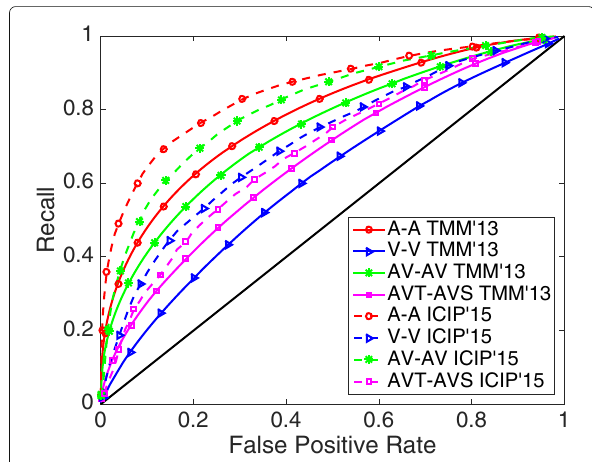
Fig. 11 Objective evaluation comparative results for TMM13 and ICIP15, where saliency classification ROC curves for the different modalities are presented